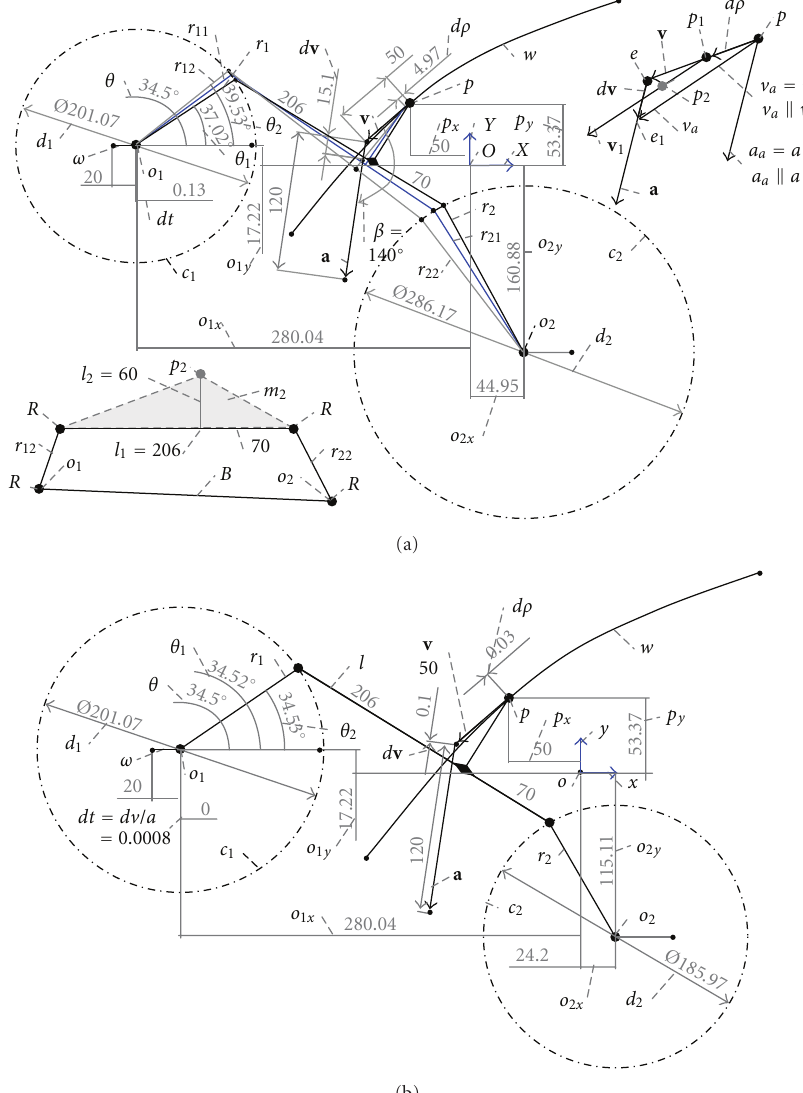
Figure 3: A planar four-bar velocity/acceleration simulation mechanism versus (a) dρ = 4 . 97, dv = 15 . 1; (b) dρ = 0 . 03, dv = 0 . 1.